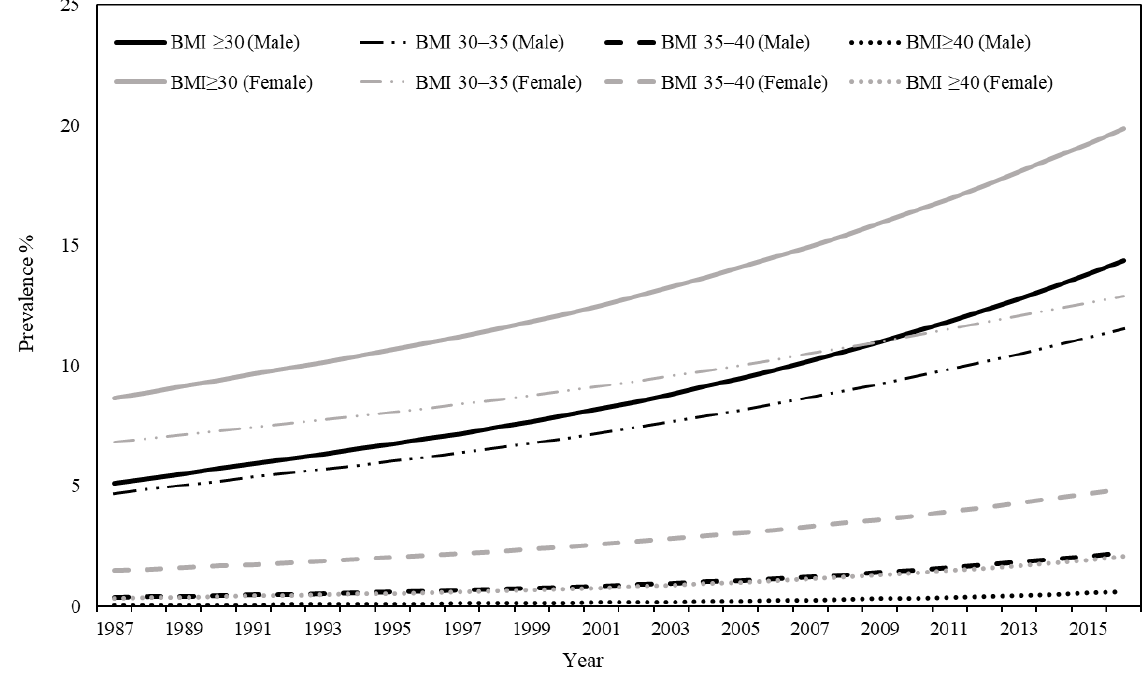
Figure 1. Trend of obesity between 1990 and 2016 in Uzbekistan. The burden of ischemic heart disease in Uzbekistan between 1990 and 2019 is shown in Table 2. In 2019, the age-standardized incidence rate for men was 1178.4 per 100,000 population (N = 84.349) and 873.9 for women (N = 59,386), respectively. The number of deaths due to ischemic heart disease was 40,615 for men and 34,886 for women, which accounted for 36.1% and 38.4% of all-cause death, respectively.